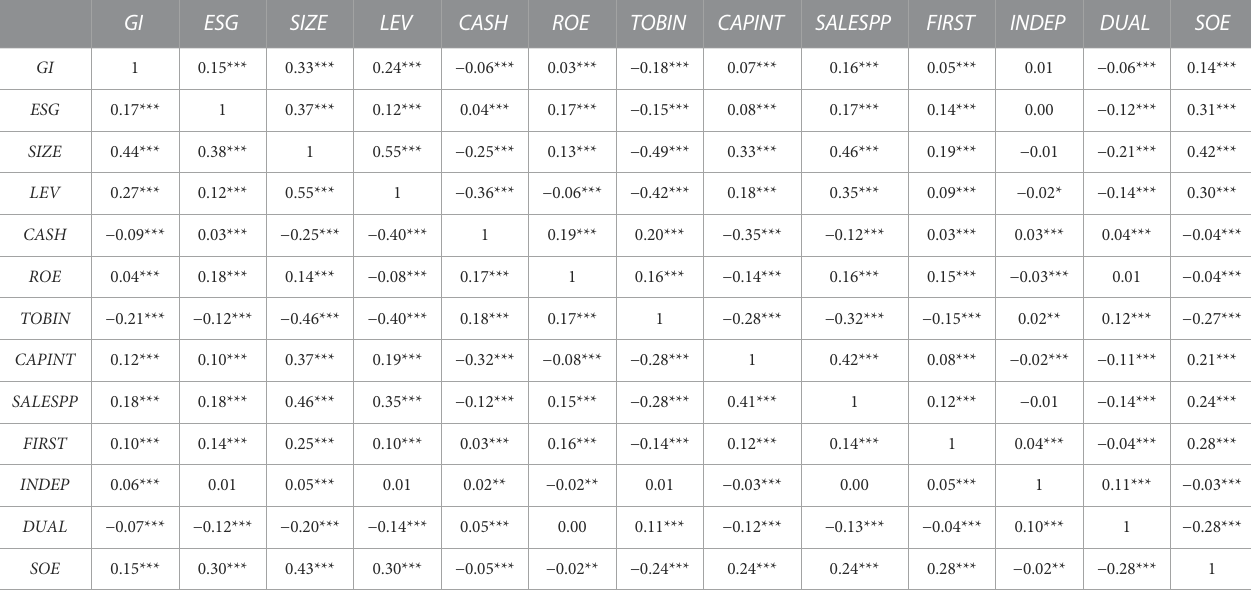
TABLE 2 Correlations